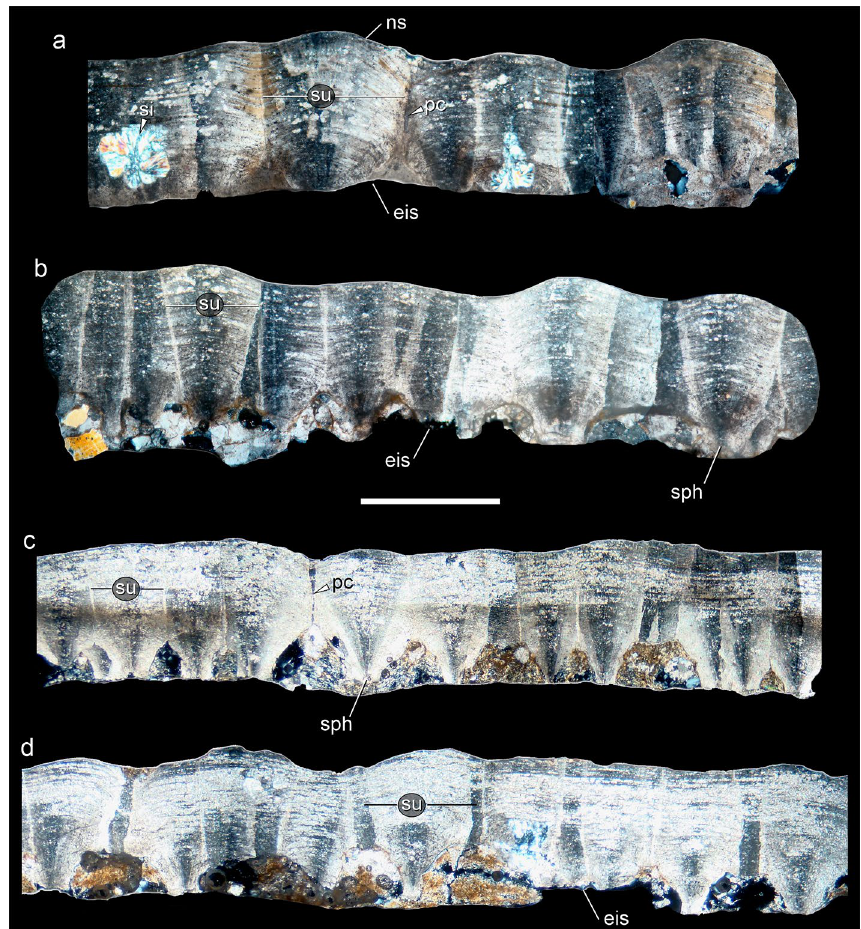
Figure 4. Transmitted light microscopic views of radial thin section of eggshell fragments from Ponte Alta nesting site showing the fan-shaped eggshell units. ( a , b ) Eggshells from CPPLIP 1798 clutch. ( c , d ) Eggshells from CPPLIP 1800 and 1801, respectively. The base of a group of eggshell units may develop “football boot- studs” shape. The matrix infilling of the eggs are represented by the sand and clayey matrix visible at the bottom of the eggshells. eis eroded internal surface, ns nodular surface, pc pore canal, si silicification, sph spherulite, su shell unit. Scale bar 1